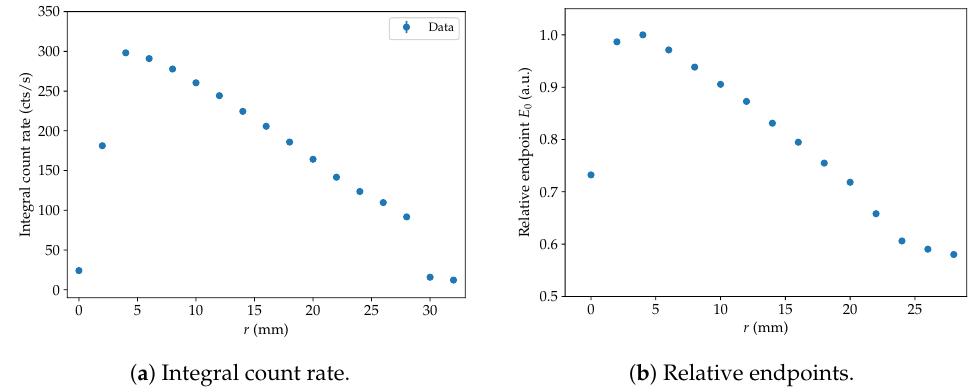
Figure 14. ( a ) Dependence of the integral count rate and ( b ) of the relative endpoint on r as observed for a 90 Sr scan. The measurements were conducted with the detector operated at a bias voltage of V B = 2000V.